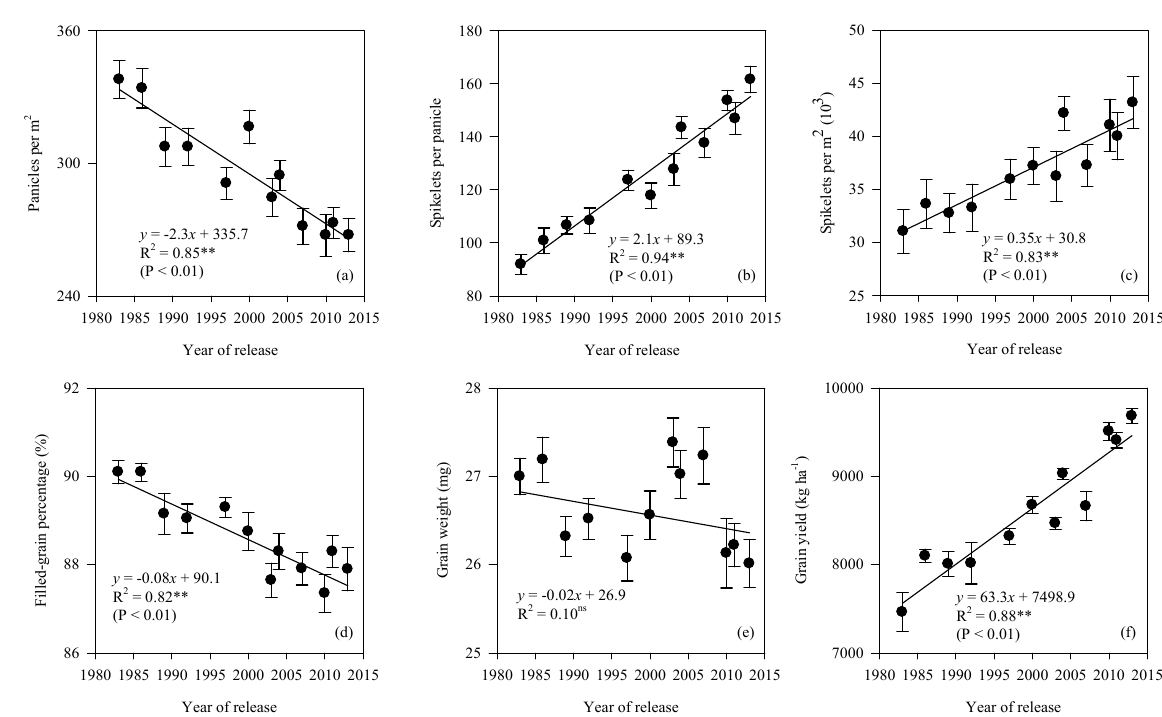
Figure 1. Relationships between year of release and panicles per m 2 ( a ), spikelets per panicle ( b ), spikelets per m 2 ( c ), filled-grain percentage ( d ), grain weight ( e ), and grain yield ( f ) of rice cultivars. Data were fitted by linear regression ( y = a x + b). In the linear regression, x was reassigned as years after 1983; for example, x was valued as 1 in 1983 and so on. **, significant at the 0.01 probability level according to the LSD test; ns, not significant at the 0.05 probability level according to the LSD test. Vertical bars represent ± standard error of the mean ( n = 6). Single panicle weight varied significantly ( p < 0.01) in rice cultivars from 2.3 g to 3.6